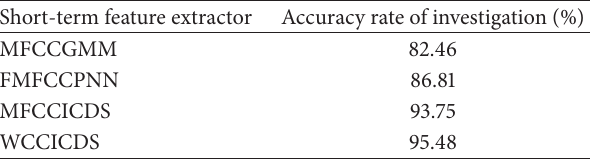
Table 3: The accuracy of investigation.